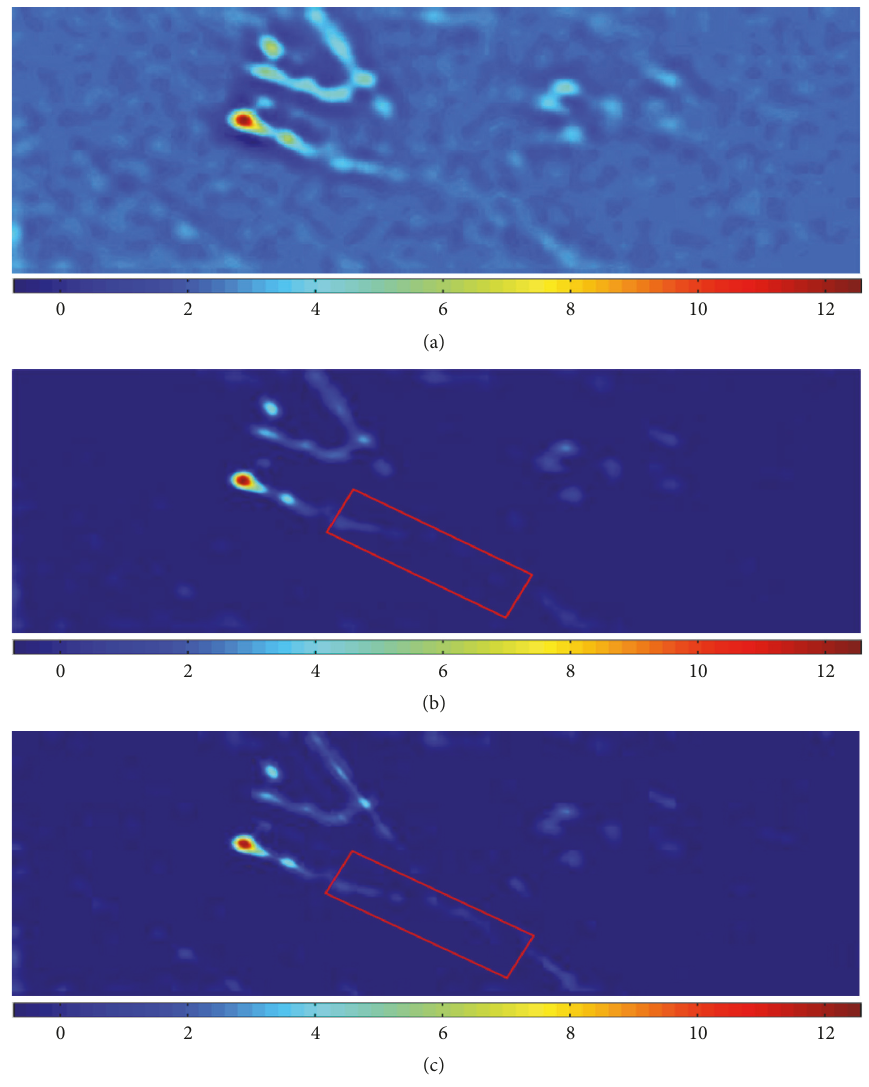
Figure 8: Denoising results of the 40th subimage.(a) The original 40th subimage.(b) The 40th subimage obtained using the iterativecleaning algorithm directly. (c) The denoised 40th subimage after MCA decomposition and fusion.